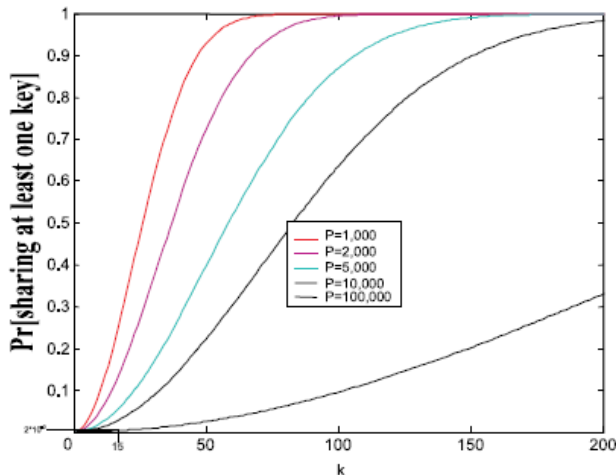
Figure 4. The probability of sharing at least one